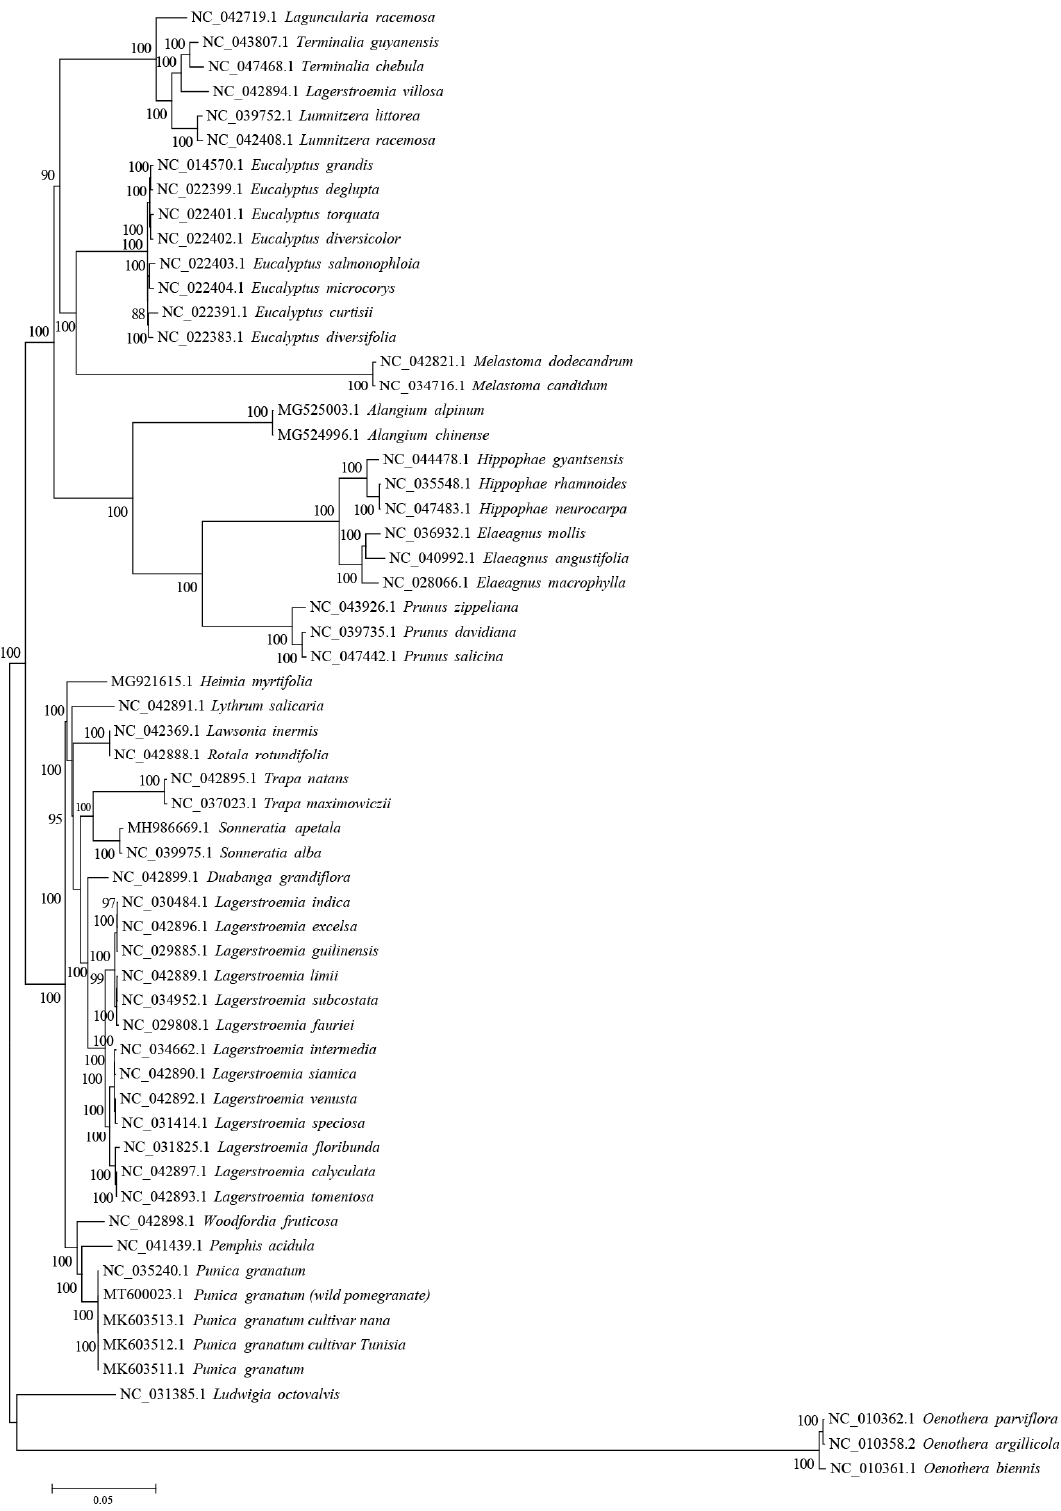
Figure 7. Phylogenetic trees of wild pomegranate species and relative genomes of the 59 species based on whole chloroplast genomes. The tree is constructed by using RAxML via the Maximum likelihood method of 1000 replications. The bootstrap interference values are displayed above the branches or near the nodes.